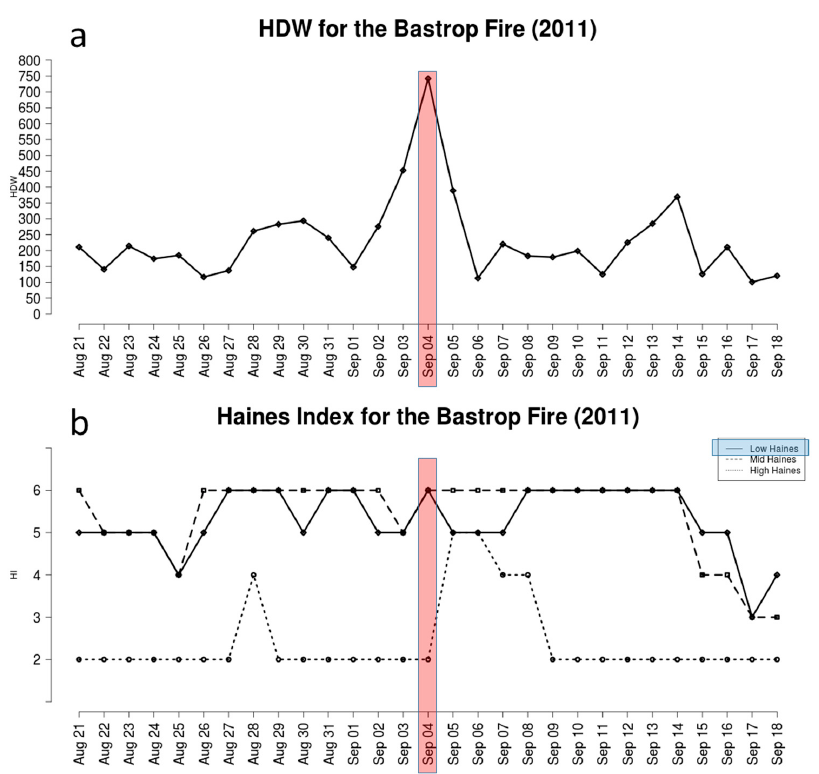
Figure 2. Time series using CFSR data at 30.0° N latitude and 97.0° W longitude from 21 August through 18 September 2011 of ( a ) HDW and ( b ) Low (solid line), Mid (dashed line), and High (dotted line) variants of the Haines Index. The vertical, shaded, red rectangles indicate the day on which the most rapid fire growth occurred on the Bastrop Fire. The Haines Index variant that is recommended for this location is shaded in